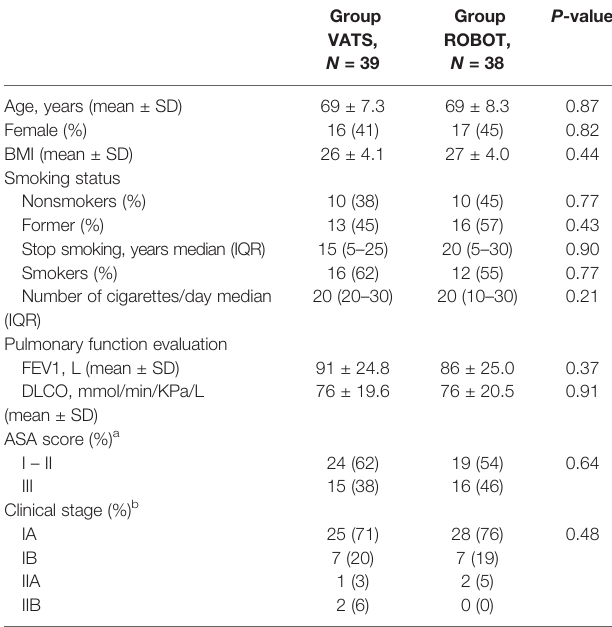
TABLE 1 | Baseline characteristics of the patients enrolled in the VATS and ROBOT